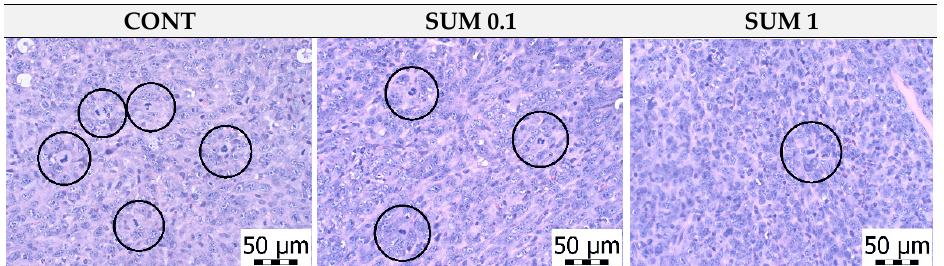
Figure 3. The mitotic activity index after treatment with R. coriaria in 4T1 tumors in Balb/c mice. The mitotic figures are highlighted in circles; H&E staining; magnification ×400.